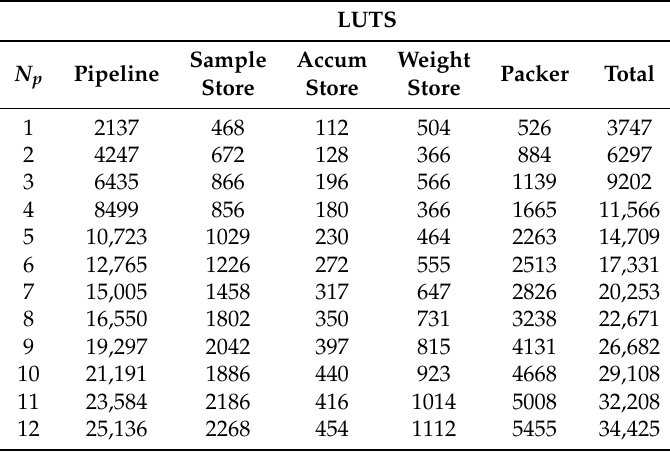
Table 2. LUT use in various stages for different N p